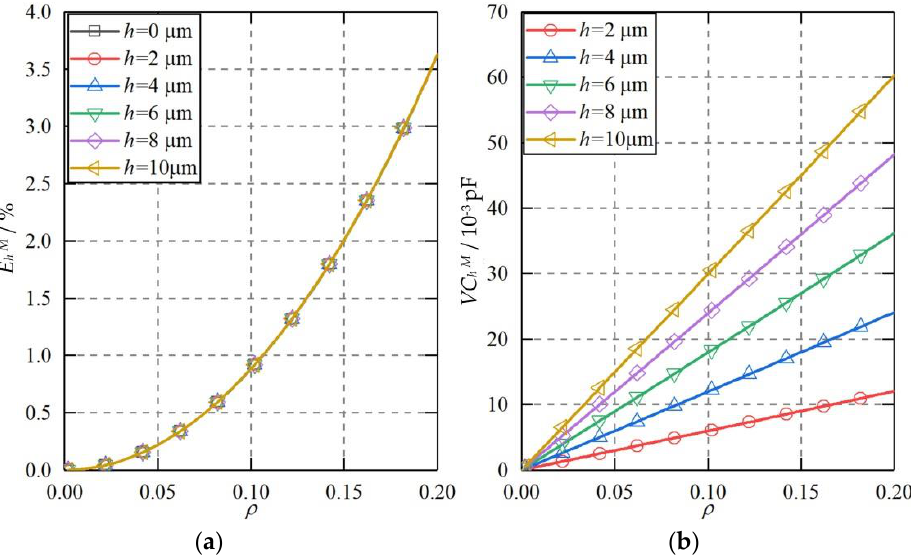
Figure 14. The theoretical capacitance error when CP S1 and CP S3 are misaligned and radial offset ( a ) Higher-order capacitance error, ( b ) variable capacitance error.